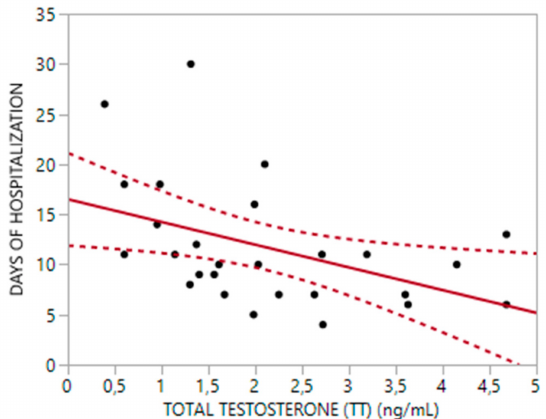
Figure 1. Relationship between Total Testosterone (TT) and Hospitalization time (R 2 = 0.19, p : 0.021).